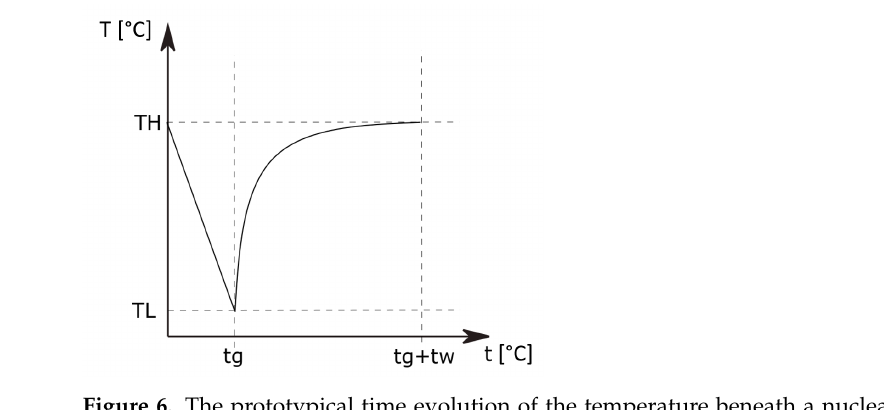
Figure 6. The prototypical time evolution of the temperature beneath a nucleation site, t g is the growth time and t w is the waiting time between a bubble take-off and the appearance of a new nucleation, based on Wang and Podowski